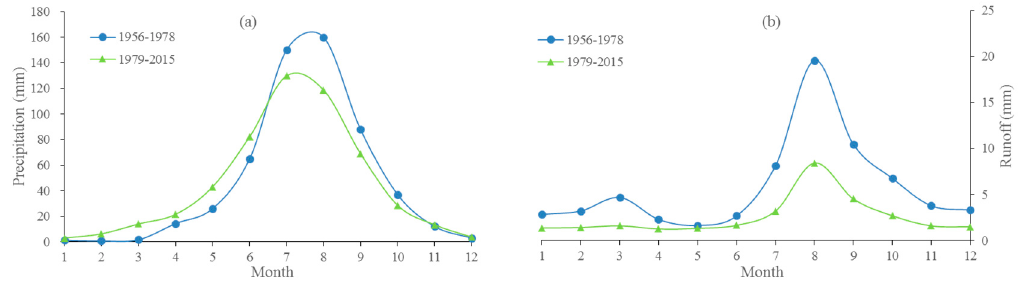
Figure 5. Average monthly P ( a ) and R ( b ) for the baseline (1956–1978) and change (1979–2015) periods.